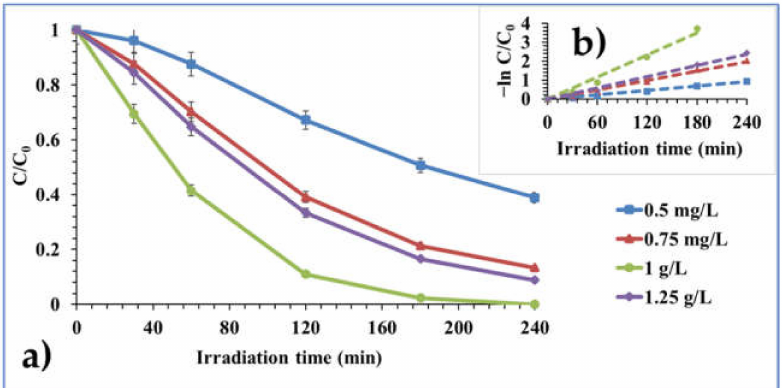
Figure 10. ( a ) Effect of catalyst dosage on the photocatalytic degradation performance of Mo/SynTiO 2 over 5 mg/L initial CBZ concentration under natural (unmodified) pH 5.84, and 365 nm irradiation; and ( b ) their corresponding photocatalytic degradation rate constant (k).